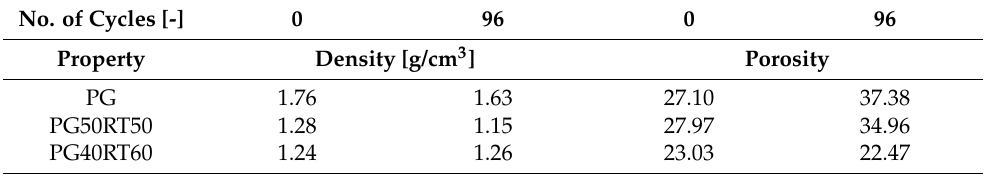
Table 2. Left: CPCMs density versus number of cycles. Right: CPCMs porosity versus number of cycles.